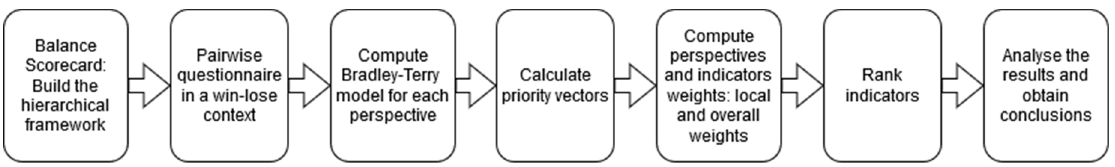
Figure 1. Process framework.